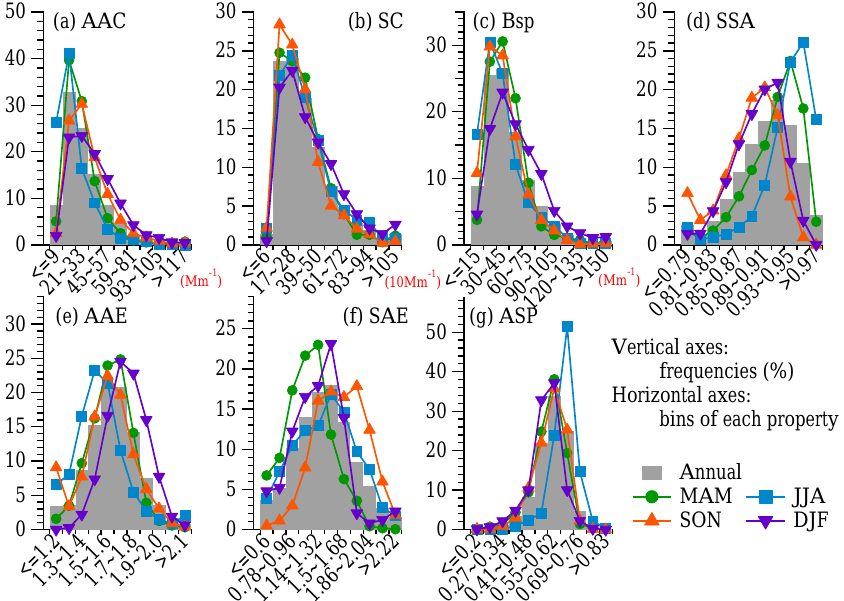
Figure 4. Frequency (%) distributions of 550nm AAC (a) , SC (b) , Bsp (c) , SSA (d) , ASP (g) , 470 / 660nm AAE (e) and 450 / 635nm SAE (f) on annual (shaded bar) and seasonal (coloured marks)